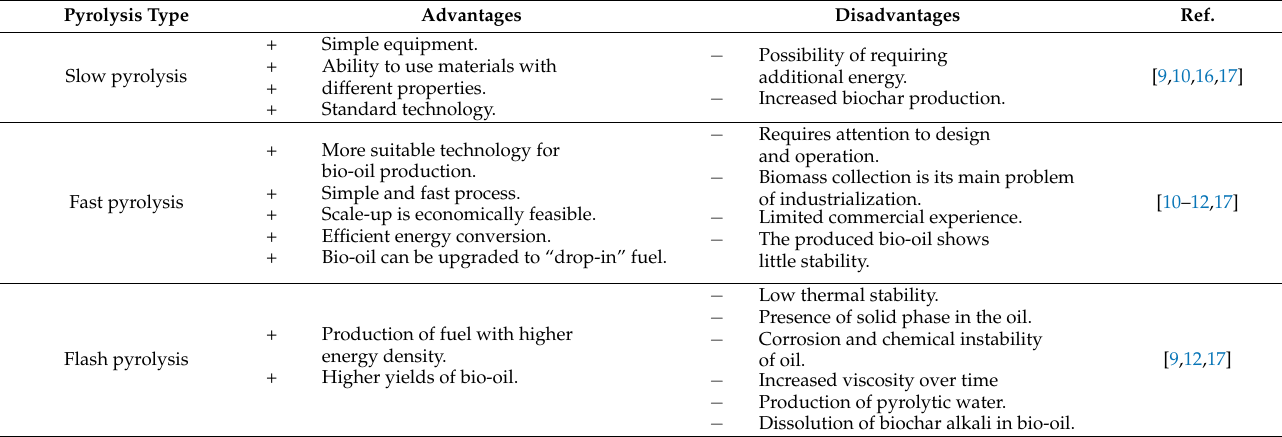
Table 5. Advantages and disadvantages of the three different pyrolysis types regarding bio-oil